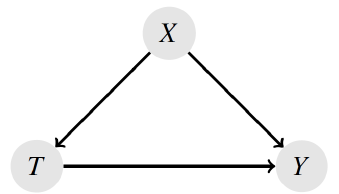
Figure 1. Directed acyclic graph showing confounding.